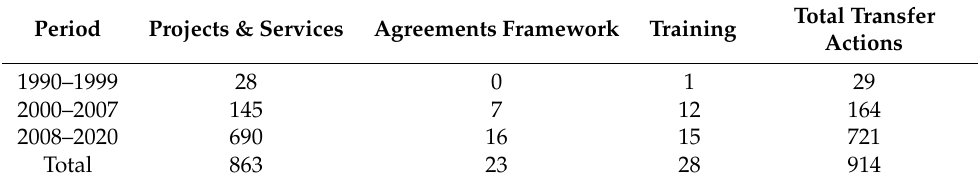
Table 6. Number of projects, services and training programmes developed by SARTI.